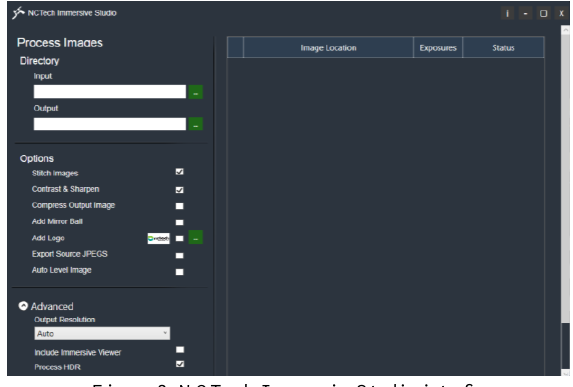
Figure 8. NCTech ImmersiveStudio interface.